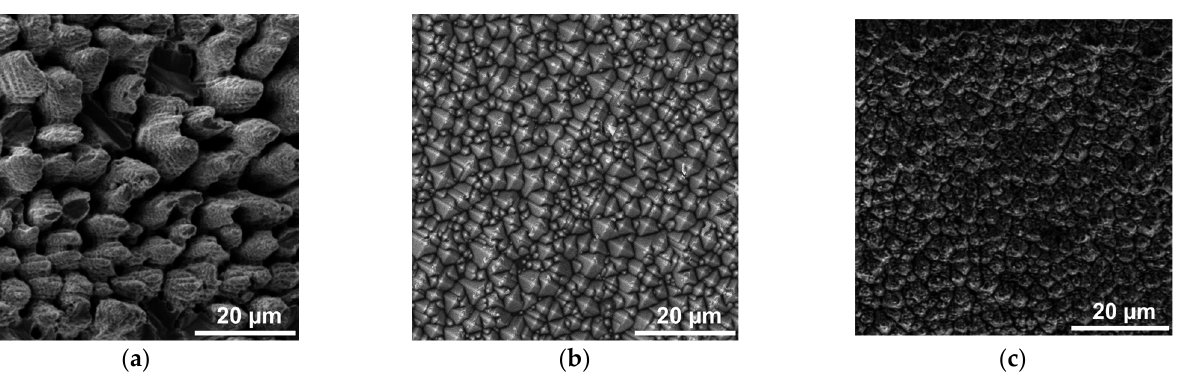
Figure 2. SEM images of structures: ( a ) Sample #1—laser texturing of a silicon cut; ( b ) Sample #2—chemical etching; ( c ) Sample #3—hybrid chemical/laser fabrication.